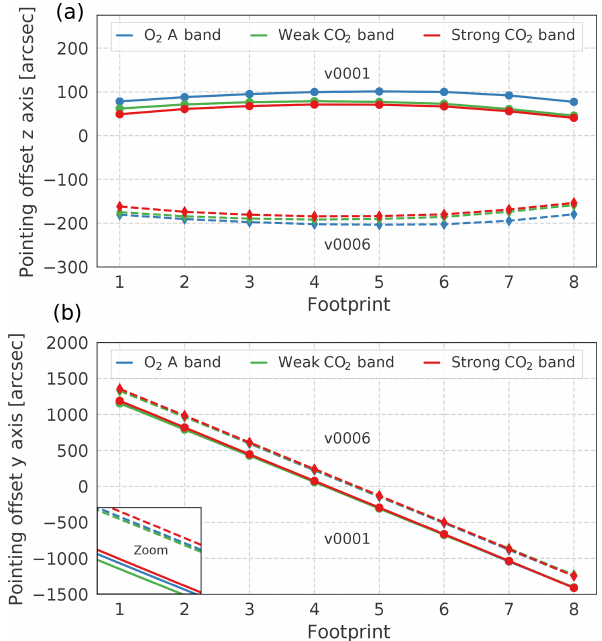
Figure 3. OCO-2 pointing offsets for each footprint and spectral band for the z axis (a) and y axis (b) derived from the pre-launch (v0001) and on-orbit (v0006)